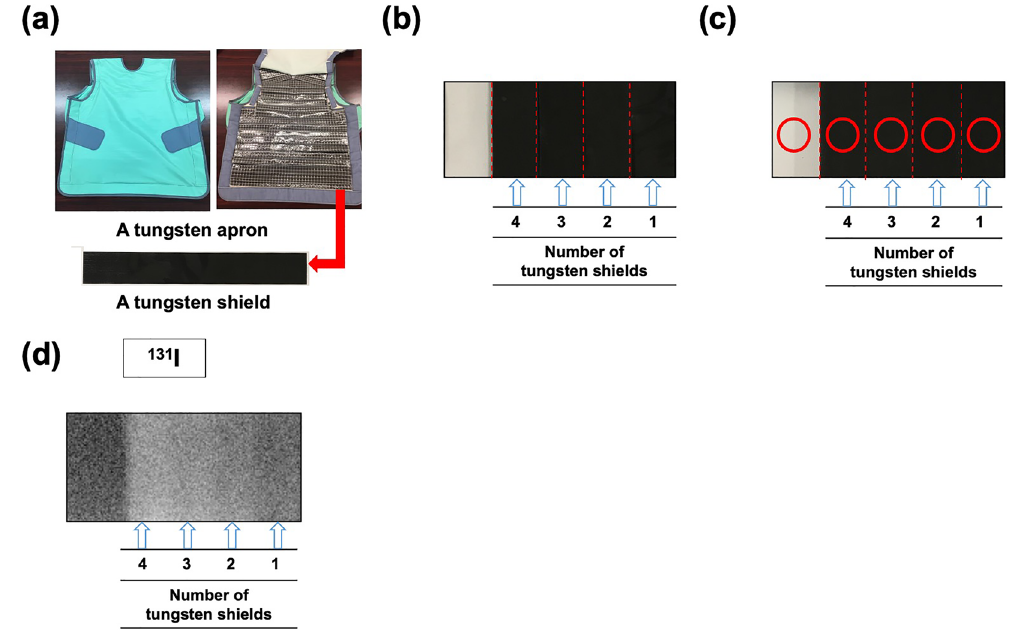
Figure 1. Gamma ray protective effects of a tungsten apron against 131 I. Attachable tungsten shields (TSs) in a commercial tungsten apron (a) were set on the surface-ray source (b) . The circular regions of interest (ROIs) (red colour circle) were set in the shielded and non-shielded areas (c) . A gamma camera was used for 131 I imaging (d)